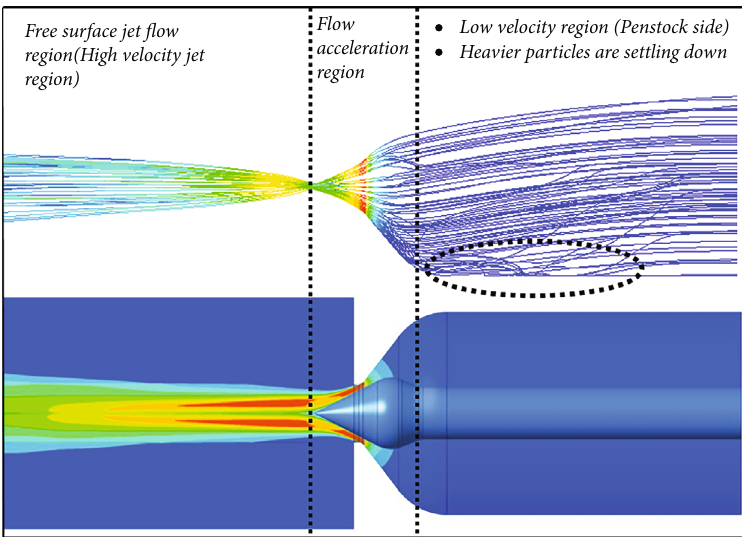
Figure 12: Sand particle tracking (50% fl ow rate). Table 4: Error in the prediction of erosion rate